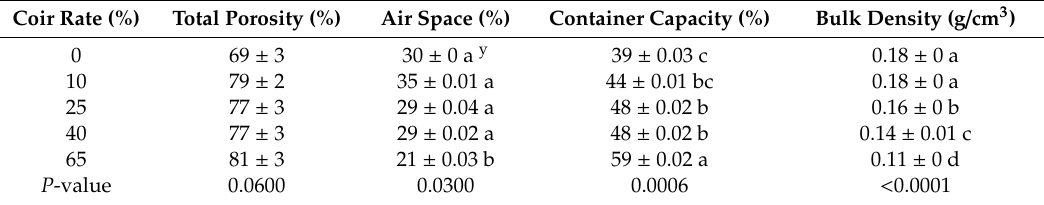
Table 1. Physical properties z of pine bark substrates amended with 0%, 10%, 25%, 40% or 65% of coir by volume (n = 3).